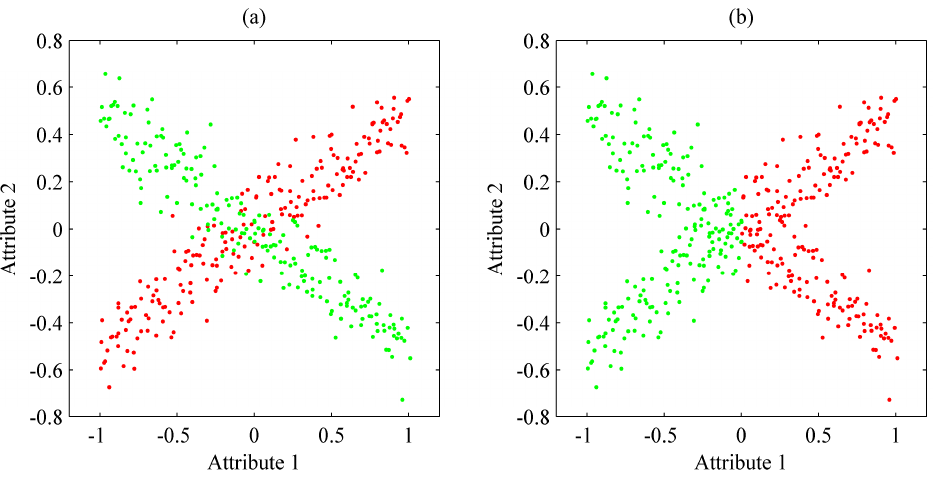
Figure 1. An example of the weakness of heuristic clustering methods. ( a ) Model-based methods such as Gaussian Mixture Model (GMM) can separate the two distinctive relationships of the two attributes, but ( b ) heuristic methods such as k-means clustering cannot.